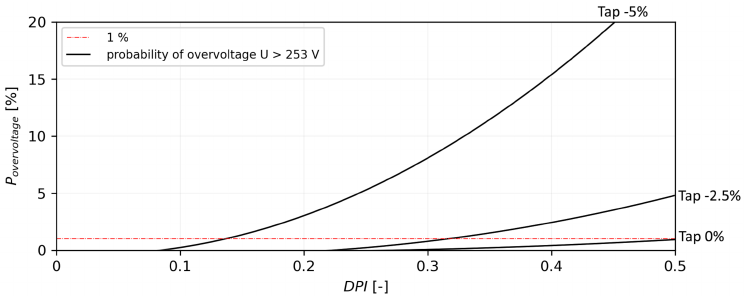
Figure 13. CDF calculated for overvoltage in the network for V2 scenario. Undervoltages below 0.85 U n occurred for tap 0% even without any PV integration, Figure 14. This leaves only the possibility of using tap − 2.5% for increasing PVHC to 31.5%, Table 3. In this tap position, there are significant undervoltages below 1.1 U n . However, their probability was lower than 0.01%.